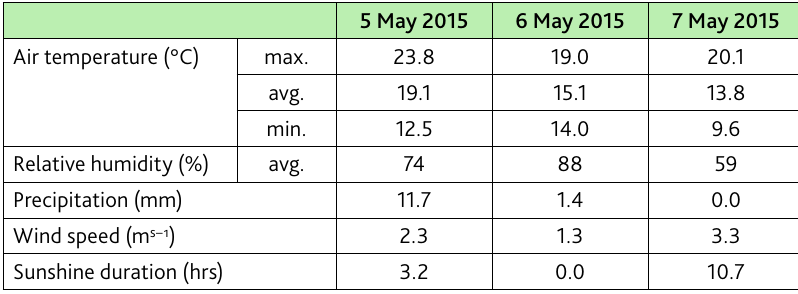
Table 2. Weather conditions on 5–7 May 2015 at the meteorological station Olomouc-Holice